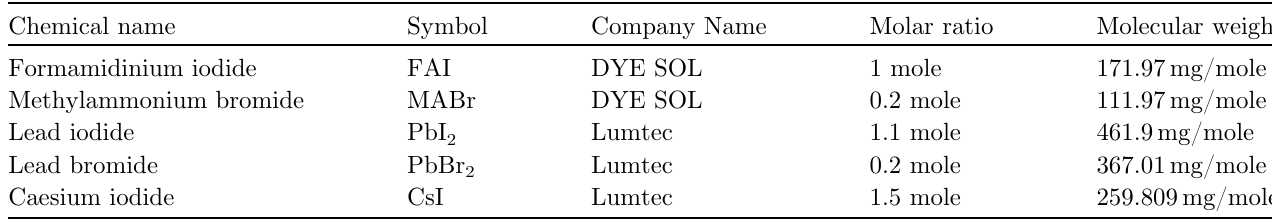
Table 1. Main materials used to prepare the perovskite